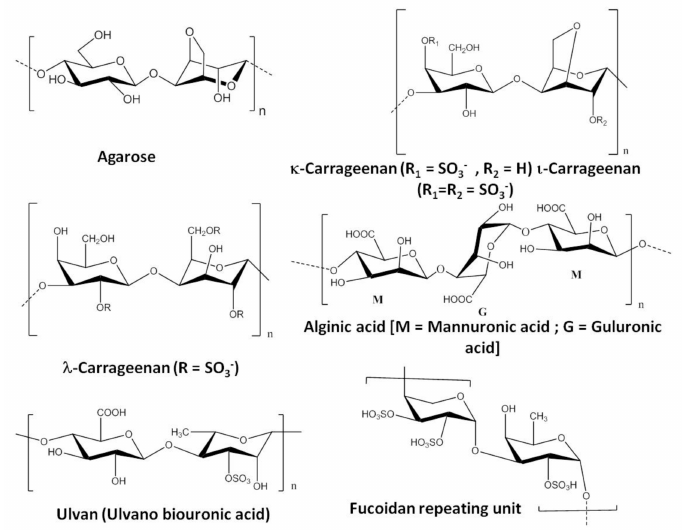
Figure 1. Repeating units of few commercially important seaweed polysaccharides